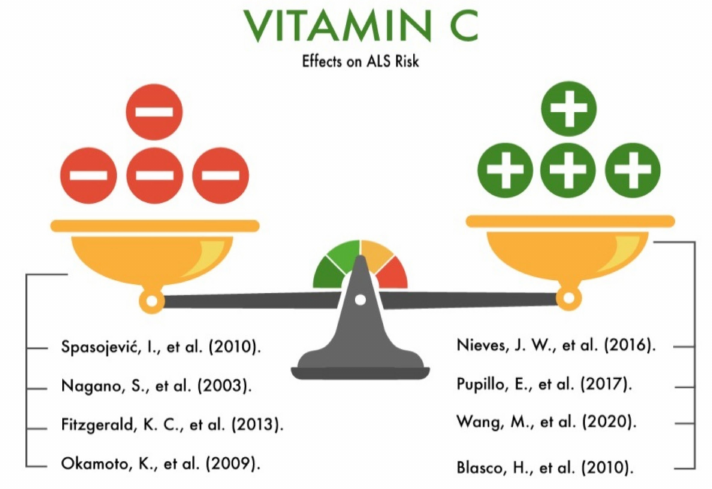
Figure 8. The effect of vitamin C on the risk of developing amyotrophic lateral sclerosis